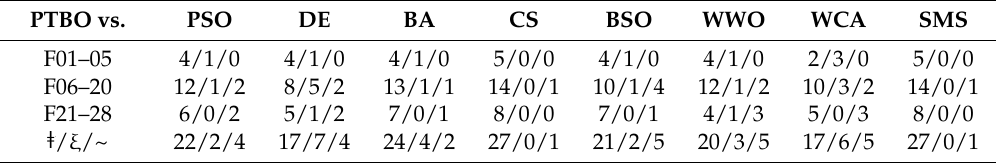
Table 11. The total results of solution accuracy for the 28